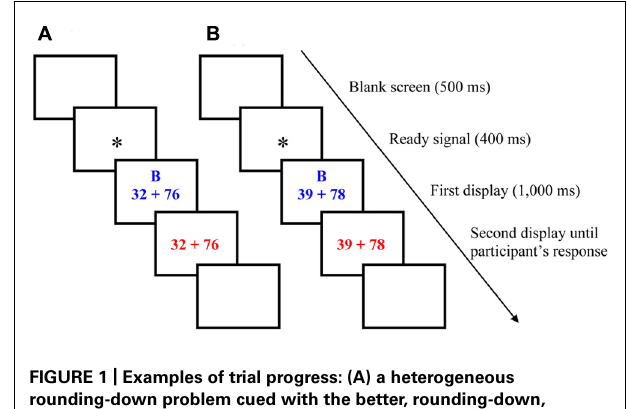
FIGURE 1 | Examples of trial progress: (A) a heterogeneous rounding-down problem cued with the better, rounding-down, strategy, and (B) a homogeneous rounding-up problem cued with the poorer, rounding-down, strategy.